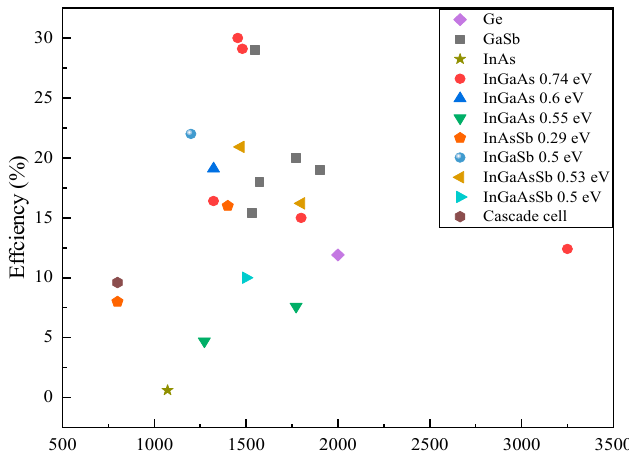
Radiation Temperature (K) Figure 3. Record TPV cell efficiencies for various materials Ge [195], GaSb [3,131,134], InAs [204], Figure 3. Record TPV cell efficiencies for various materials Ge [196], GaSb [3,131,134], InAs [204],